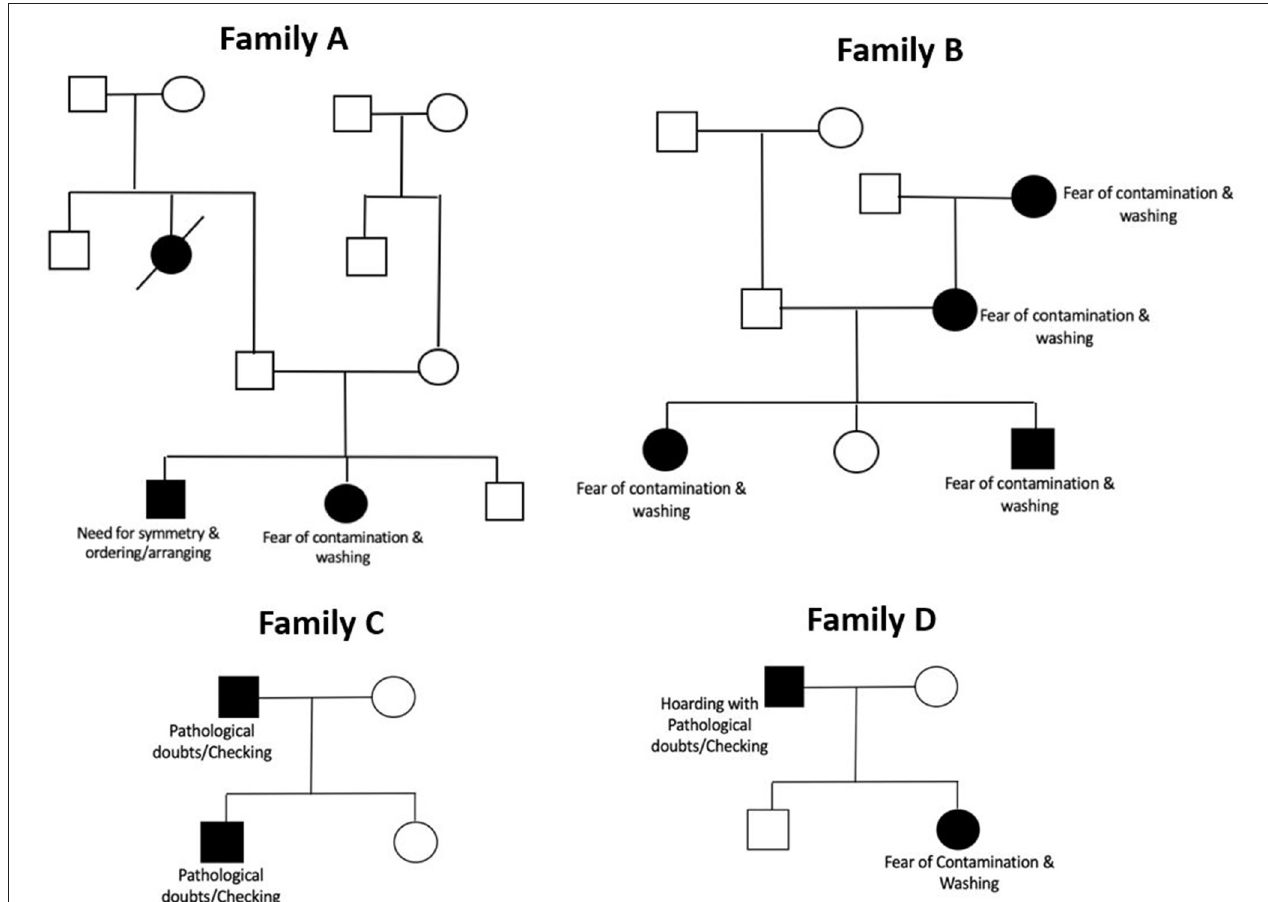
FIGURE 1 | Representative pedigrees from the sample showing principal symptoms in affected member. The pedigrees have been illustrated using standardized pedigree nomenclature (57). Boxes represent male sex, and circles represent female sex. Black shading within a box/circle indicates the disease affectation status (OCD), while an unshaded box/circle indicates that the individual is unaffected. Diagonal line through a square/circle indicates deceased status.